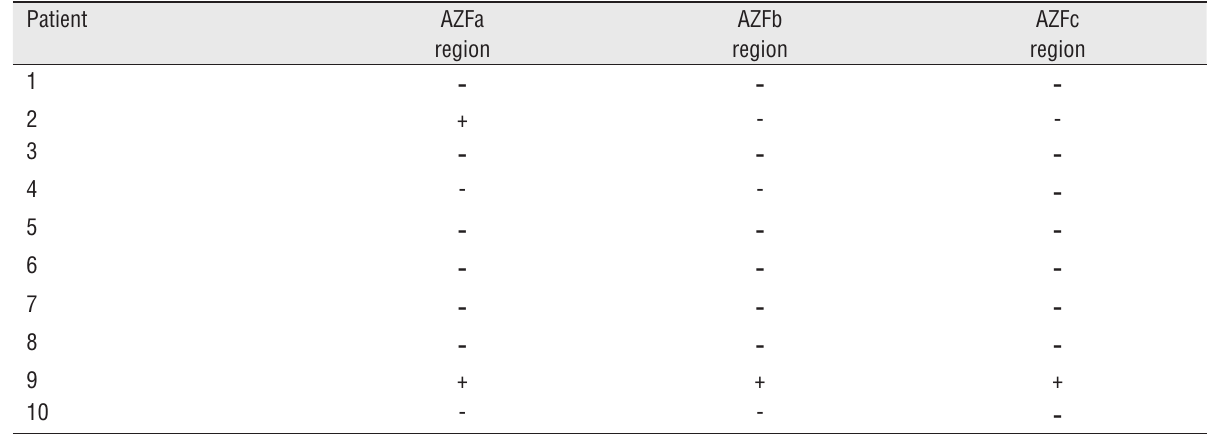
Table 3 - AZf region analysis of the patients.